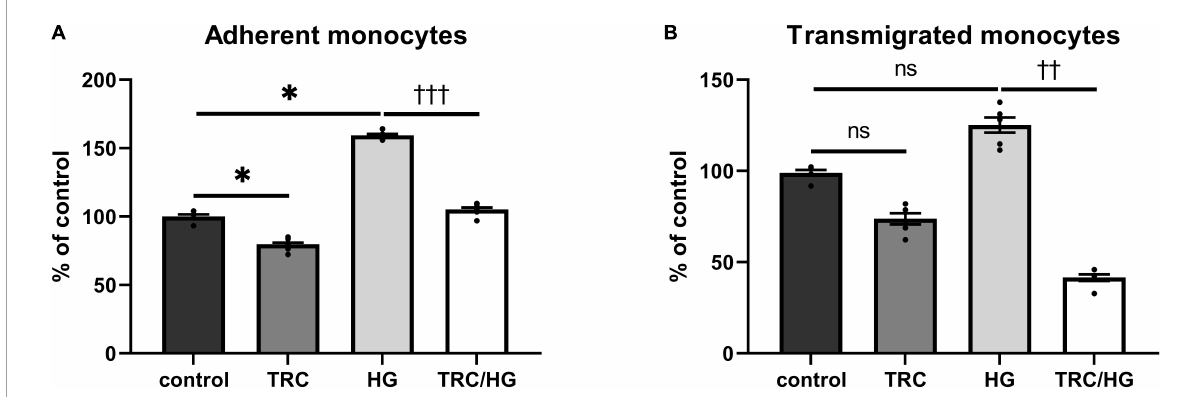
FIGURE9 Effect of TRC105 on hyperglycemia-induced adhesion and transmigration of monocytes through HAoECs monolayer. (A) adherent monocytes; (B) transmigrated monocytes. For the detailed experimental design, please see Figure 1 . Data are presented as mean ± S.E.M ( n = 6). ns, p ≥ 0.05; * p < 0.05, using Kruskal–Wallis test for comparisons among control, TRC, and HG, and †† p < 0.01; ††† p < 0.001, using Mann–Whitney test for comparison between HG vs . TRC/HG.